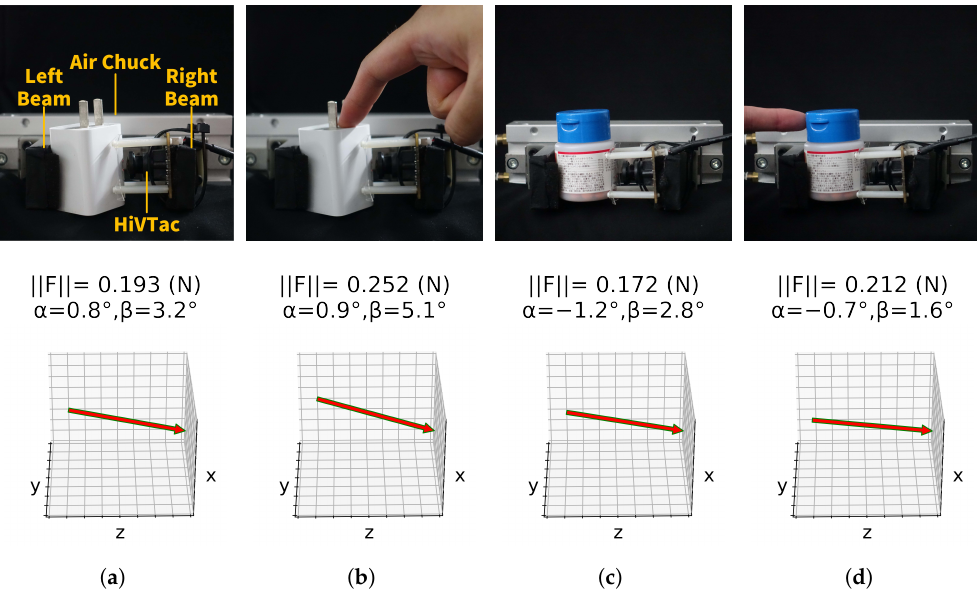
Figure 15. HiVTac in grasping tasks. Top: the proposed device grasps objects. Bottom: corresponding contact